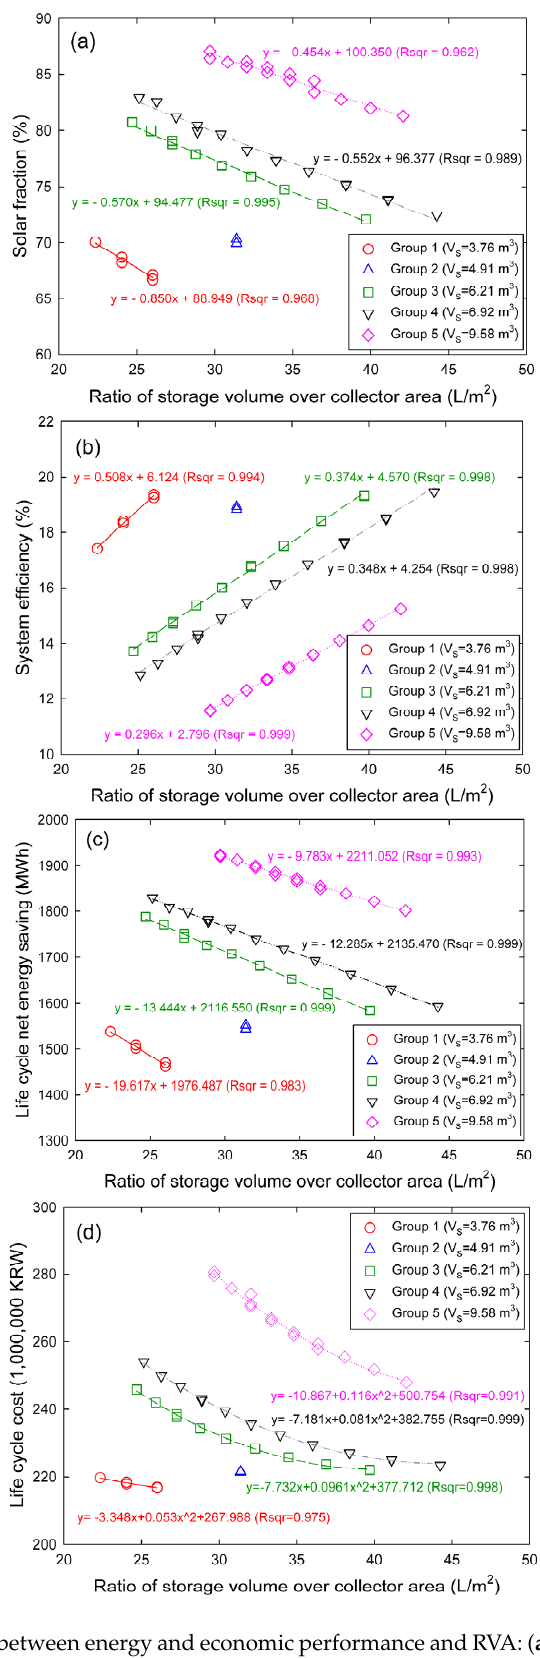
Figure 9. Correlations between energy and economic performance and RVA: ( a ) solar fraction vs. RVA; ( b ) system efficiency vs. RVA; ( c ) LCES vs. RVA; and ( d ) LCC vs. RVA.